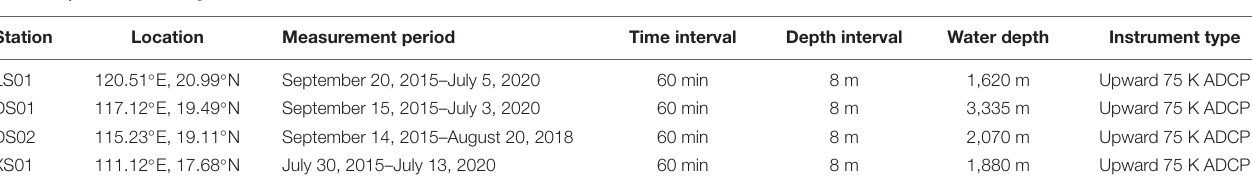
FIGURE 1 | The annual mean of the ratios between the intraseasonal and raw sea level anomaly STD (1993–2019). Solid gray line: 200 m isobath; yellow stars: mooring stations. TABLE 1 | Detailed mooring